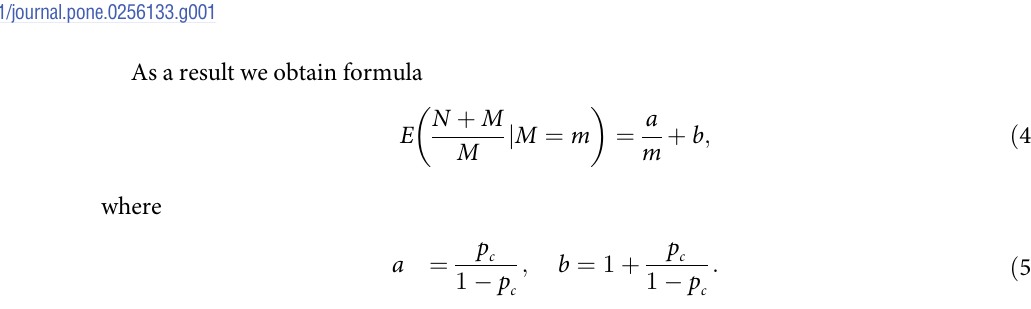
Fig 1. Memoryless source model. The memoryless source has only one state and emits in an infinite loop symbols C , V and S with probabilities p and 1 − p c − p v ,